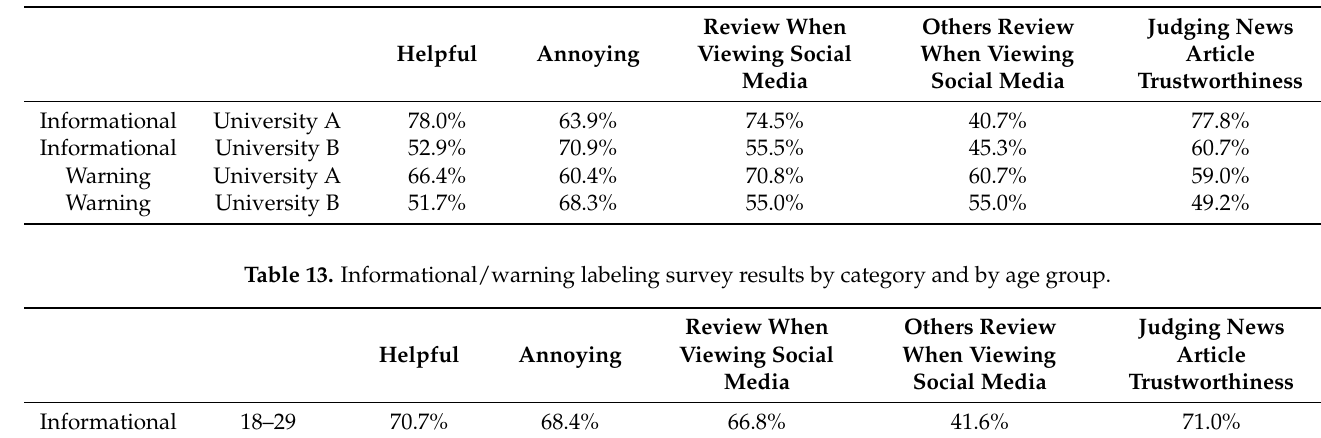
Table 12. Informational/warning labeling survey results by category and by school.